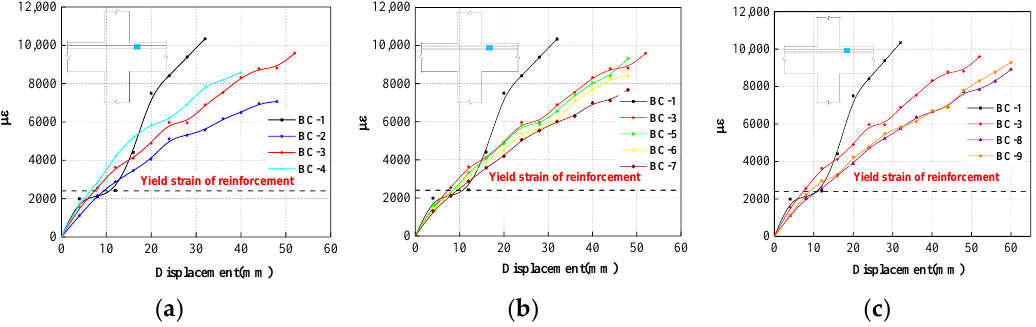
Figure 12. Maximum strains of longitudinal reinforcement. ( a ) Stirrup ratio group; ( b ) Axial pressure ratio group; ( c ) Concrete strength group.